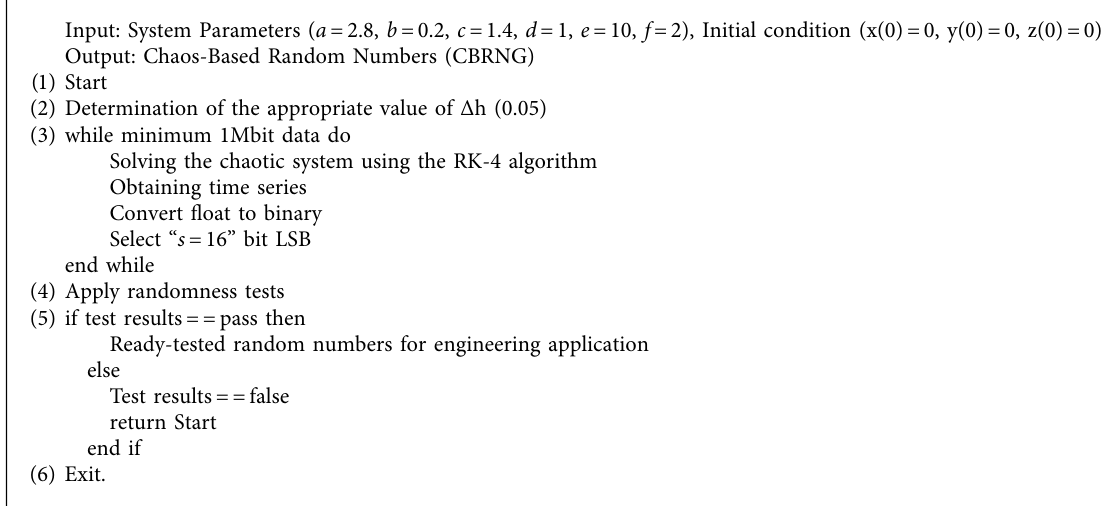
Table 1: RNG NIST-800-22 tests with a 3D chaotic system without equilibrium points.